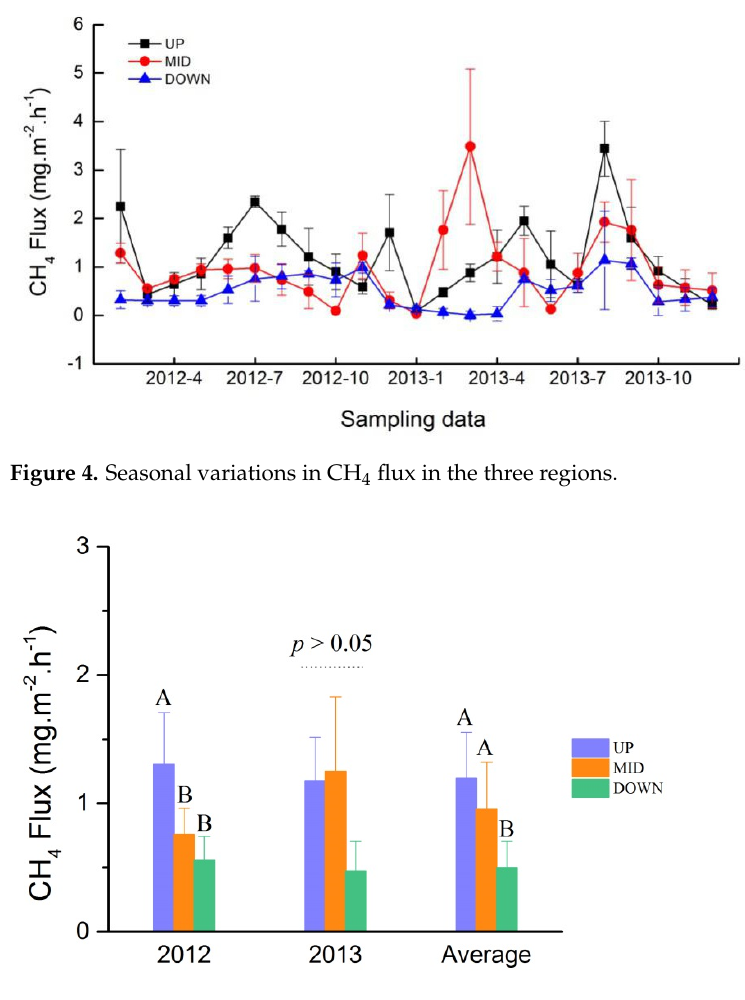
Table 2. Correlations among CH 4 fluxes and environment factors.